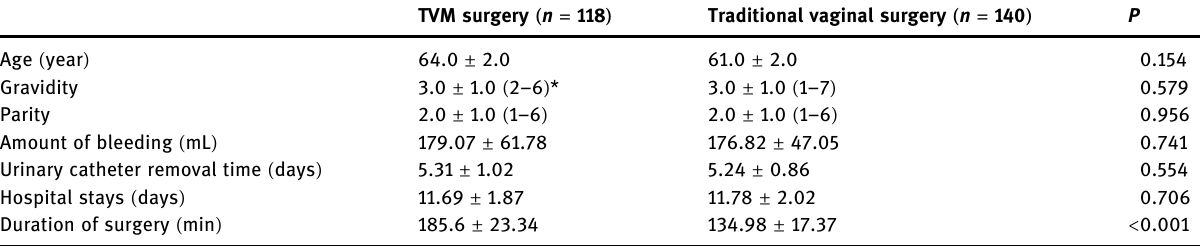
Table 1: Comparison of patient clinical characteristics, intraoperative and postoperative conditions between the two groups